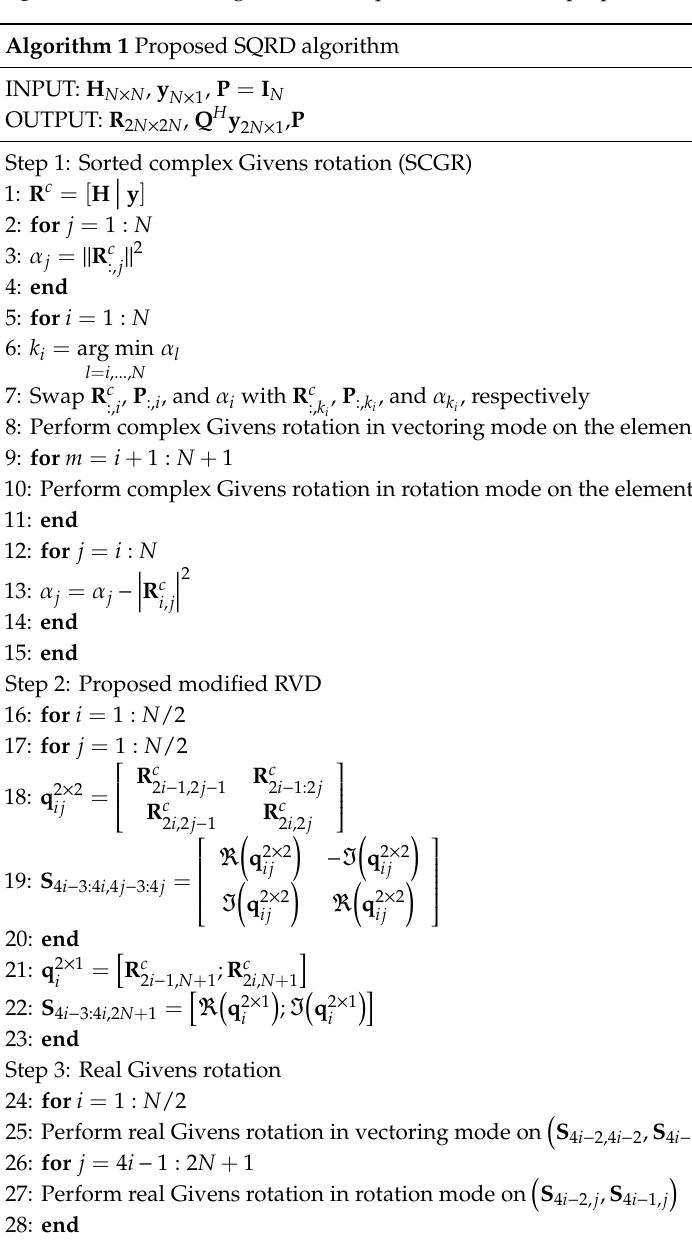
Table 1. Complexity of different Givens rotation (GR)-based QR decomposition schemes.